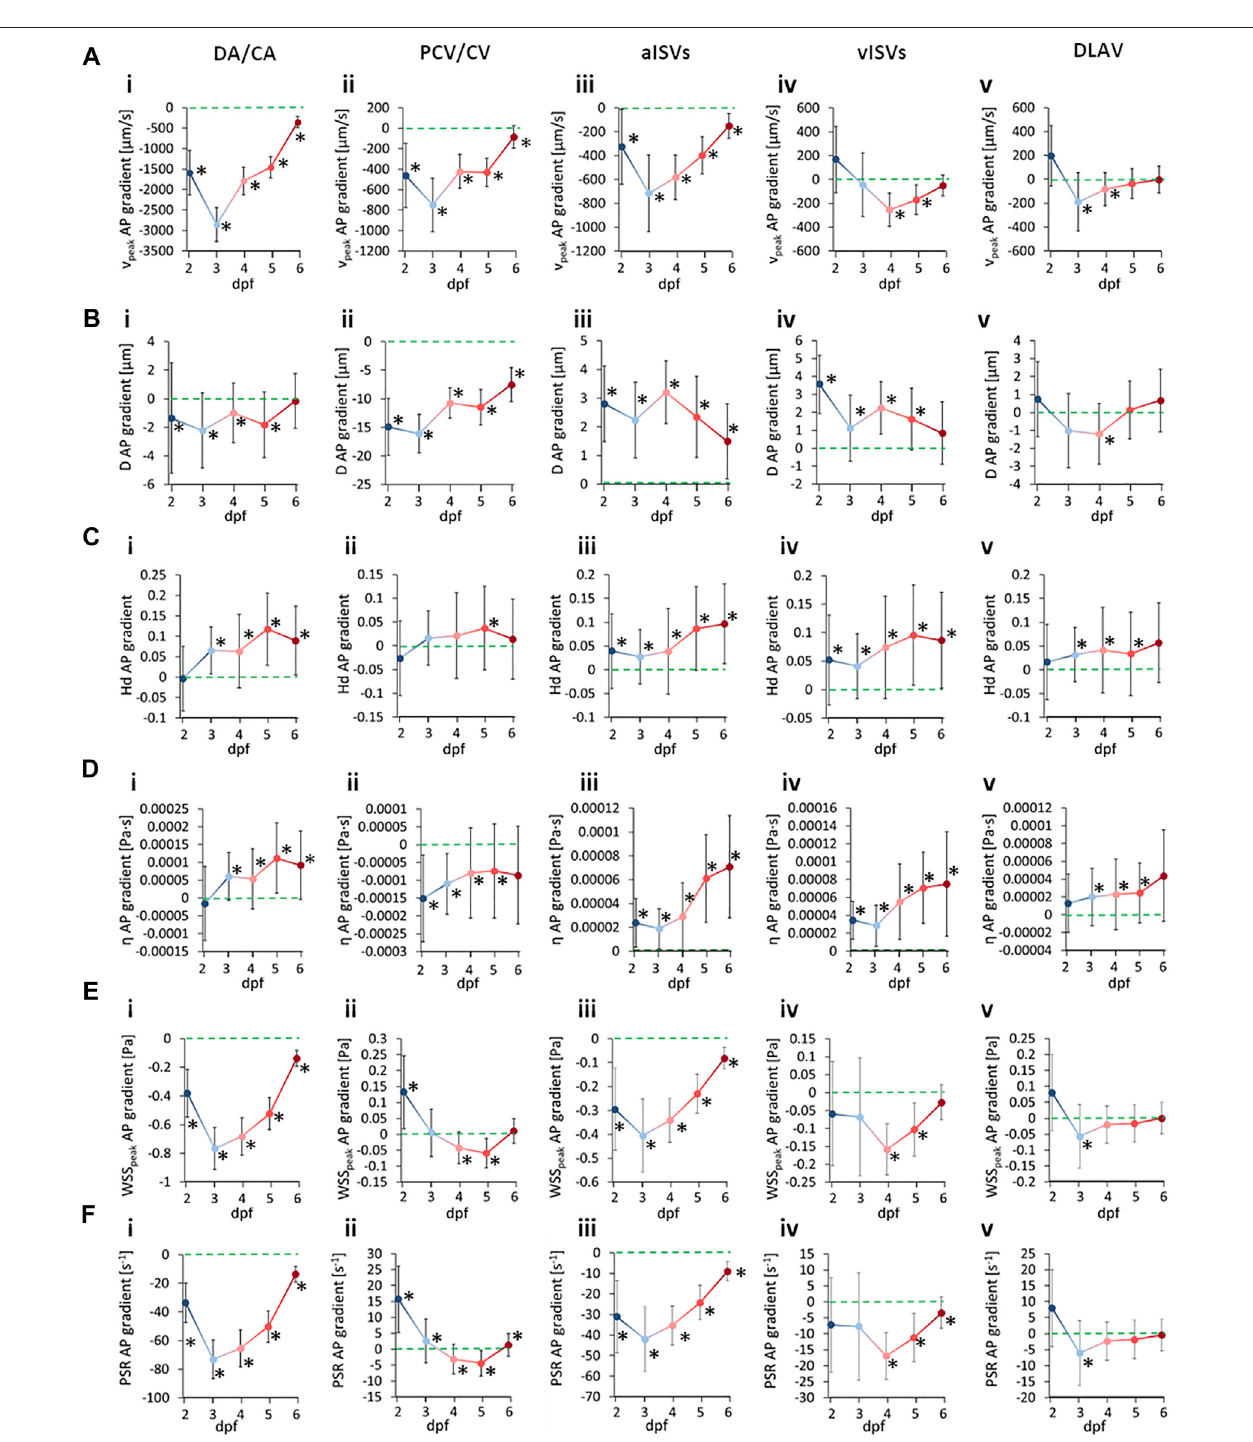
FIGURE 9 | Developmental patterns of the anterior-to-posterior (AP) gradients in morphological and hemodynamic quantities in the zebra fi sh trunk vasculature. CirclesindicatethehemodynamicAPgradientobtainedfromlinearregression fi ttingofthepooledAPdata,whiskerbarsindicatethestandarderroroftheregressionand *symbolsdenotestatisticallysigni fi cantgradientsfromtheslopeT-test( p < 0.05). (A) APgradientsfor V peak intheDA/CA (i) ,PCV/CV (ii) ,aISVs (iii) ,vISVs (iv) andDLAV (v) . (B) APgradientsin D intheDA/CA (i) ,PCV/CV (ii) ,aISVs (iii) ,vISVs (iv) andDLAV (v) . (C) APgradientsfor H d intheDA/CA (i) ,PCV/CV (ii) ,aISVs (iii) ,vISVs (iv) and DLAV (v) . (D) AP gradients for η in the DA/CA (i) , PCV/CV (ii) , aISVs (iii) , vISVs (iv) and DLAV (v) . (E) AP gradients for WSS peak in the DA/CA (i) , PCV/CV (ii) , aISVs (iii) , vISVs (iv) and DLAV (v) . (F) AP gradients in PSR in the DA/CA (i) , PCV/CV (ii) , aISVs (iii) , vISVs (iv) and DLAV (v) .